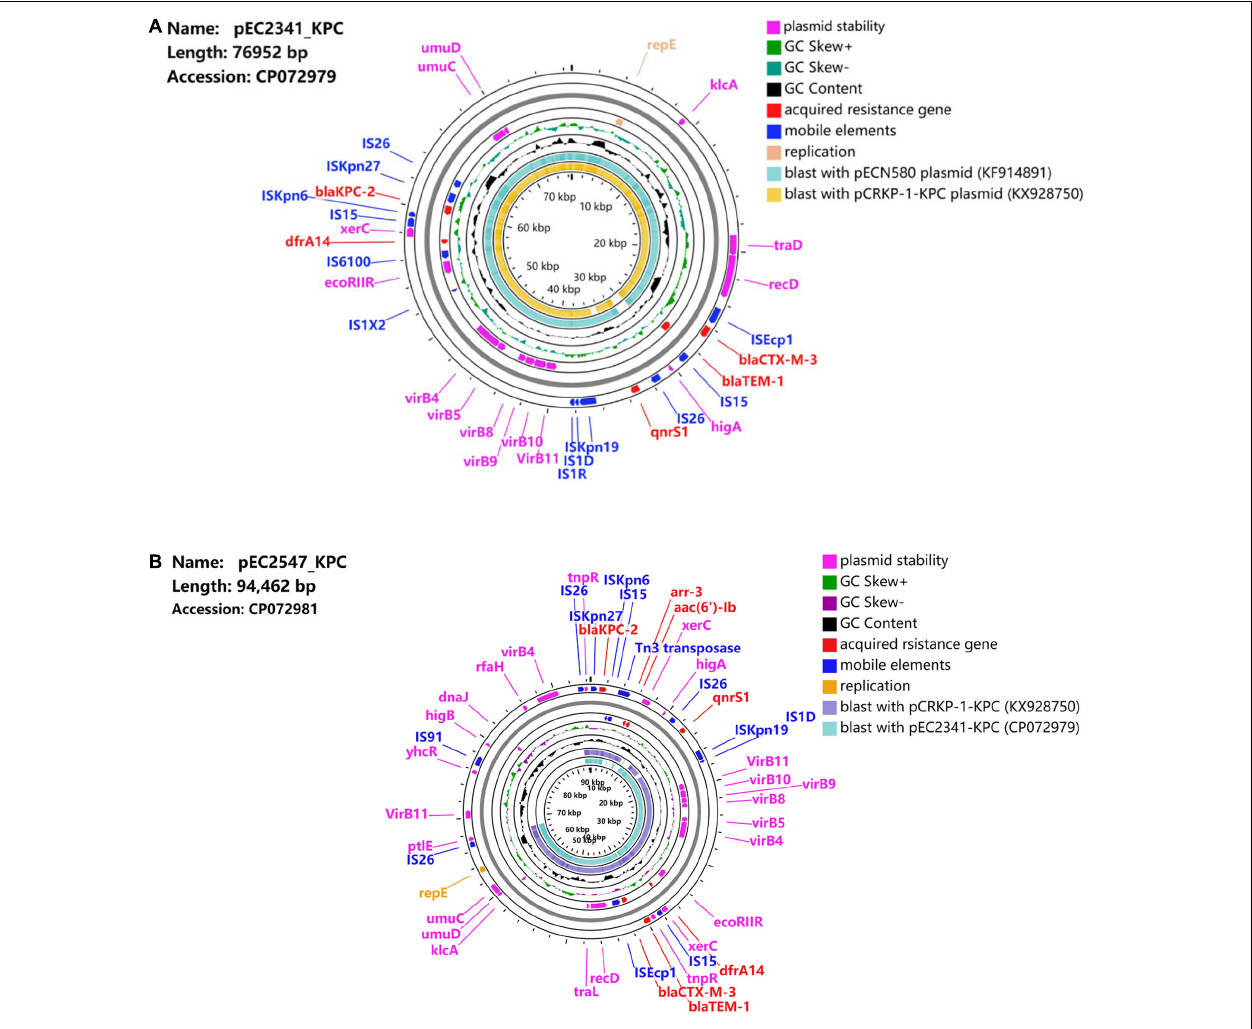
FIGURE 1 | (A) Schematic map of plasmid pEC2341_KPC. Sequence alignment between pECN580 (accession number KF914891) and pCRKP-1-KPC (accession number KX928750) is the outer circle in orange and teal. (B) Schematic map of plasmid pEC2547_KPC. Sequence alignment between pEC2341-KPC